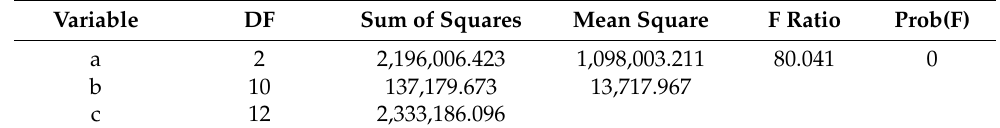
Table 8. The variance analysis.